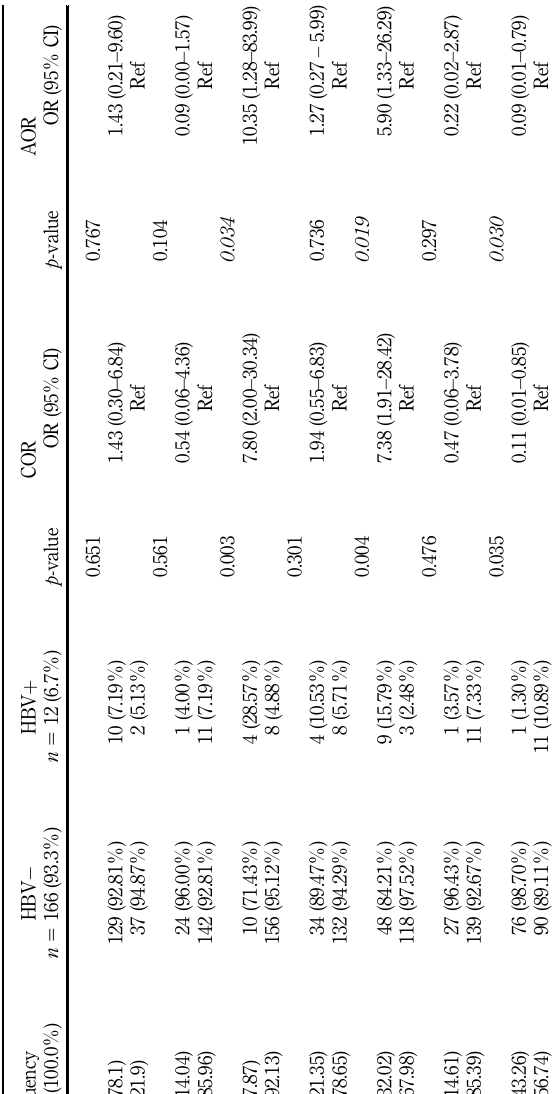
Table 2. Bivariate and multivariate logistic regression analysis of risk factors of hepatitis B